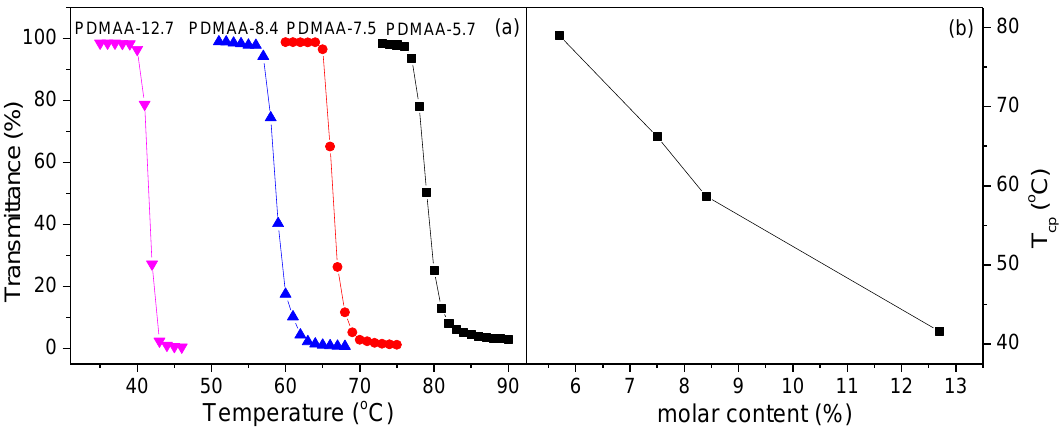
Figure 4. Transmittance as function of temperature ( a ) and T cp related to molar content of PyBEMA in copolymer ( b ) for 5 g/L pyrenyl-containing PDMAA copolymers in aqueous solution.